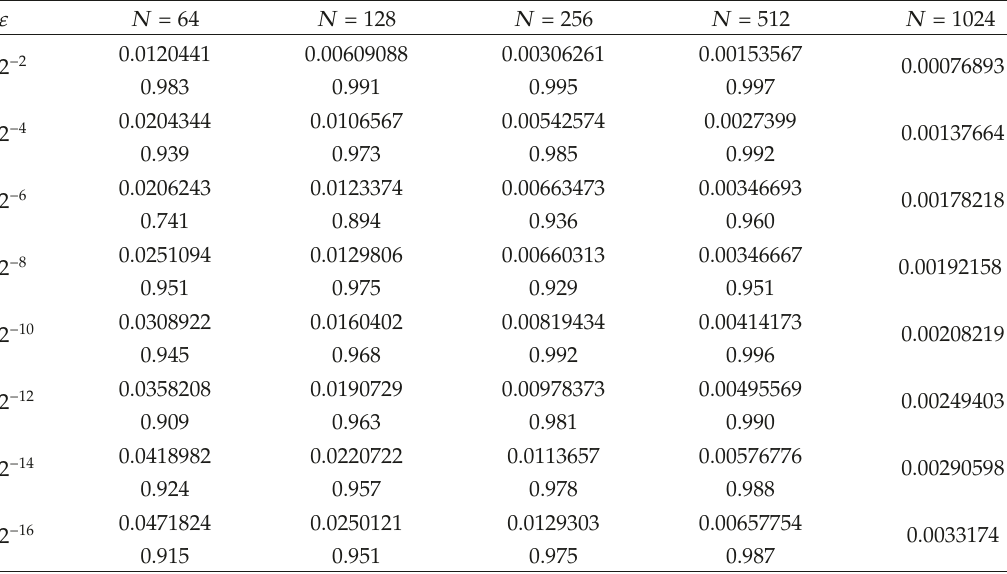
Table 2: Maximum Errors and Rates of Convergence for the Bakhvalov-Shishkin Mesh on ω